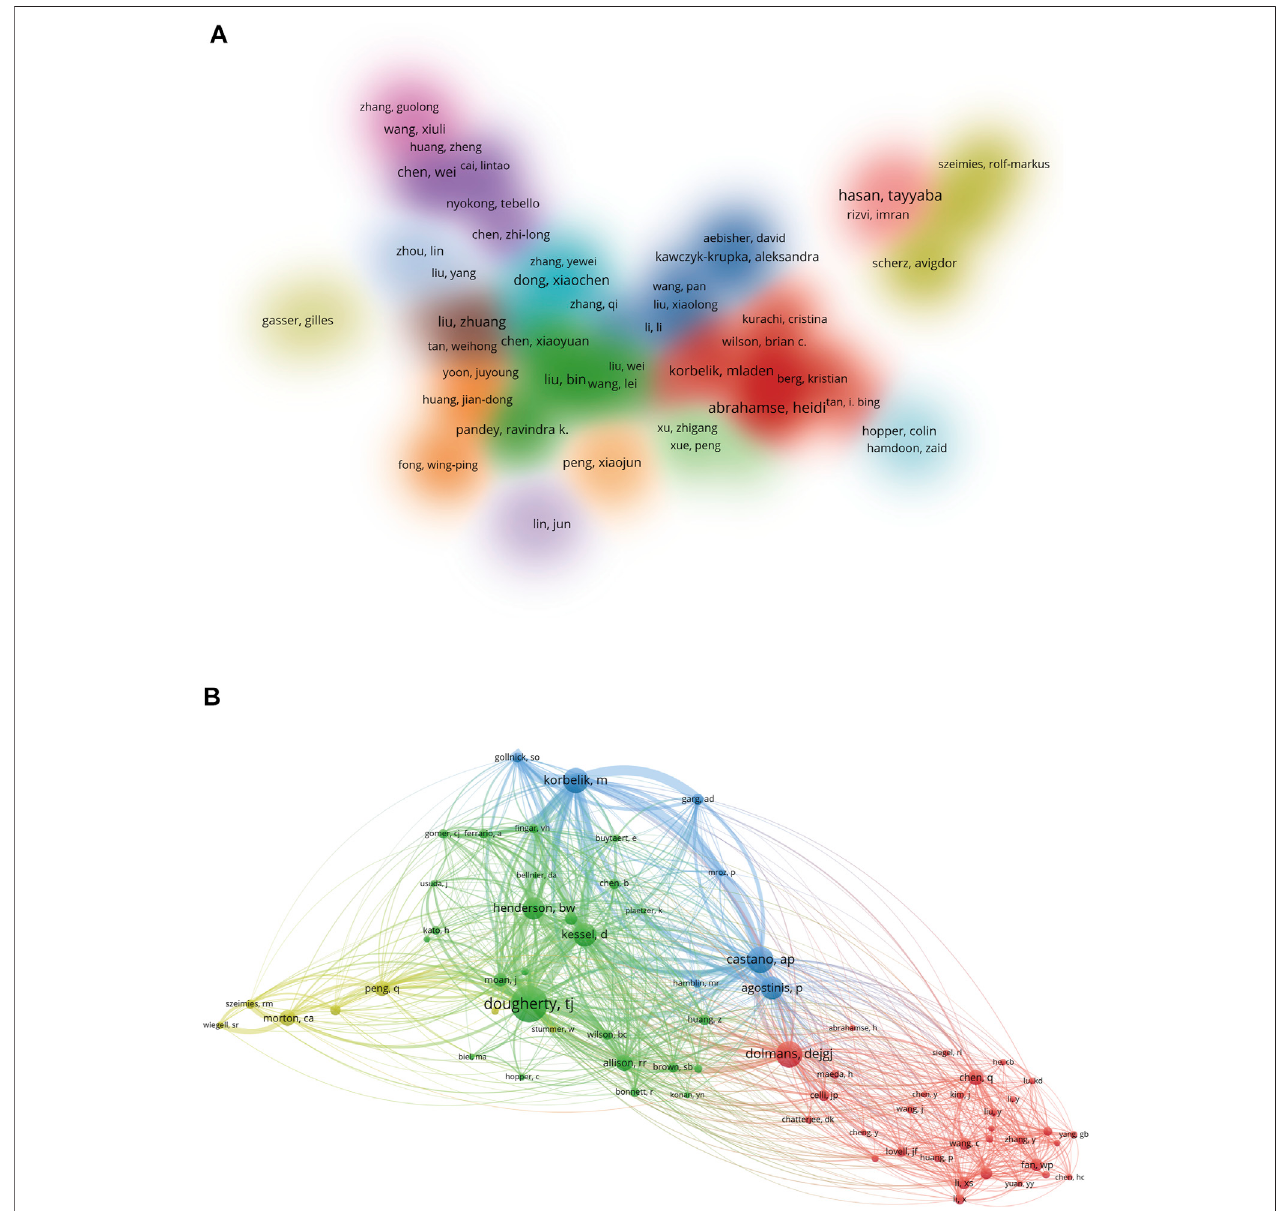
FIGURE 5 | (A) Author co-authorship analysis by VOSviewer. In this cluster density map, authors with close relationship are allocated to one cluster with the same color. (B) Authorco-citationanalysisbyVOSviewer.Inthisnetworkvisualizationmap,each noderepresents anauthor,andthelinesconnectingthenodesrepresentthe co-citation